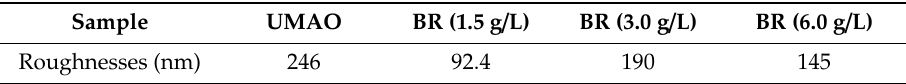
Table 3. Roughness values of various